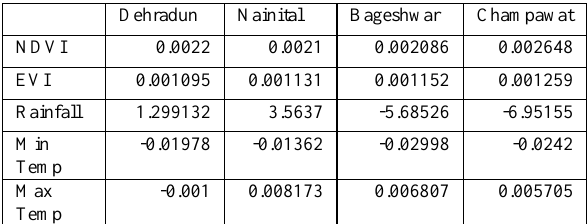
Table 2. Rate of Change in parameters during